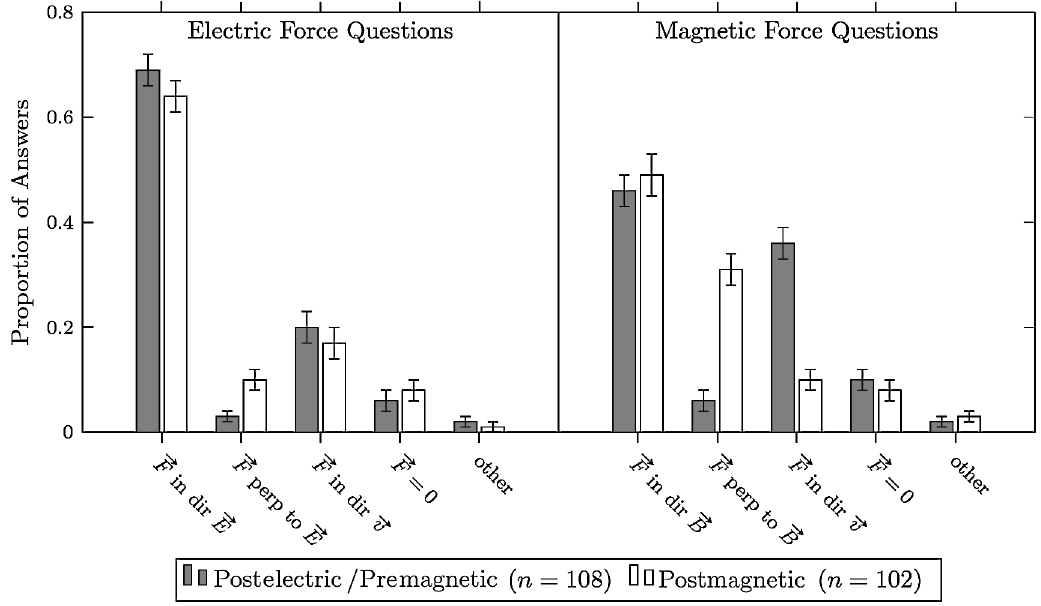
FIG. 6. Results showing how students’ answers to electric and magnetic force questions changed from before to after instruction in magnetism. Fields were depicted using